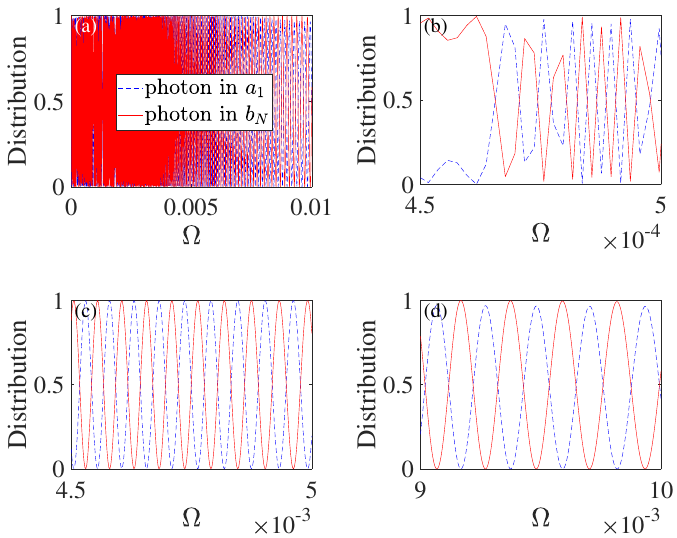
Figure 3. ( a ) The distributions of photons at the two-end resonators for the evolved final state versus the varying rate Ω . ( b – d ) The detailed pattern of the photon distributions at the two-end resonators. The evolution time is 2 π / Ω . Other parameter takes N = 10. In the unit of − g 2